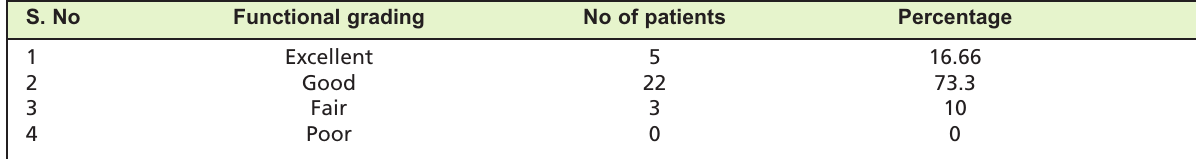
Rasmussens functional grading Table II: